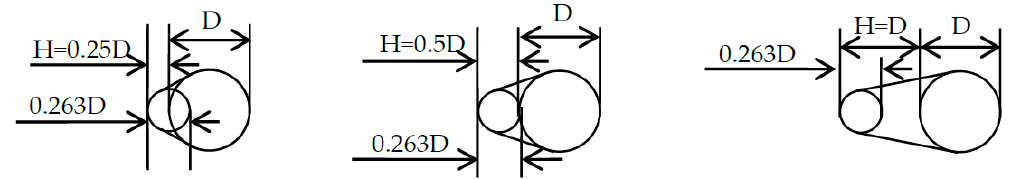
Figure 1. Cross sectional dimensions of crescent iced conductors.